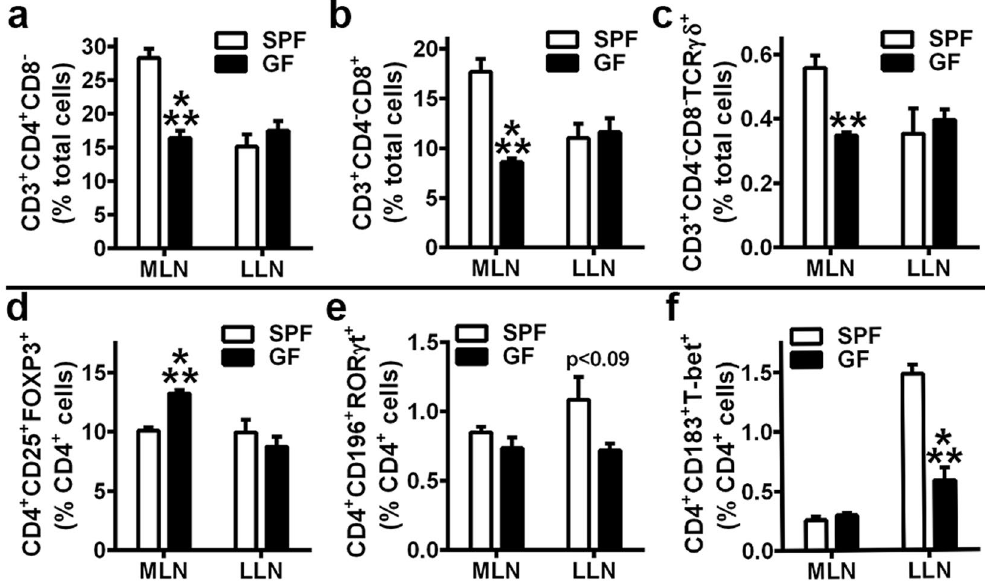
Figure 7. Draining gut and liver lymph node T-cell hematopoiesis. ( a – f ) 12 week-old male SPF & GF mice were euthanized; Mesenteric lymph node (MLN) and liver lymph node (LLN) cells were isolated and stained for flow cytometric analysis (n = 4/gp). ( a ) % CD3 + CD4 + CD8 − (helper) T-cells, ( b ) % CD3 + CD4 − CD8 + (cytotoxic) T-cells, and ( c ) % CD3 + CD4 − CD8 − TCR γδ + (gamma delta) T-cells are expressed relative to total lymph node cells. ( d ) % CD4 + CD25 + FOXP3 + (T REG ) cells, ( e ) % CD4 + CD196 + ROR γ t + (T H 17) cells, and ( f ) % CD4 + CD183 + T-bet + (T H 1) cells are expressed relative to CD4 + cells. Data are reported as mean ± SEM. ** p < 0.01 vs. SPF; *** p < 0.001 vs.